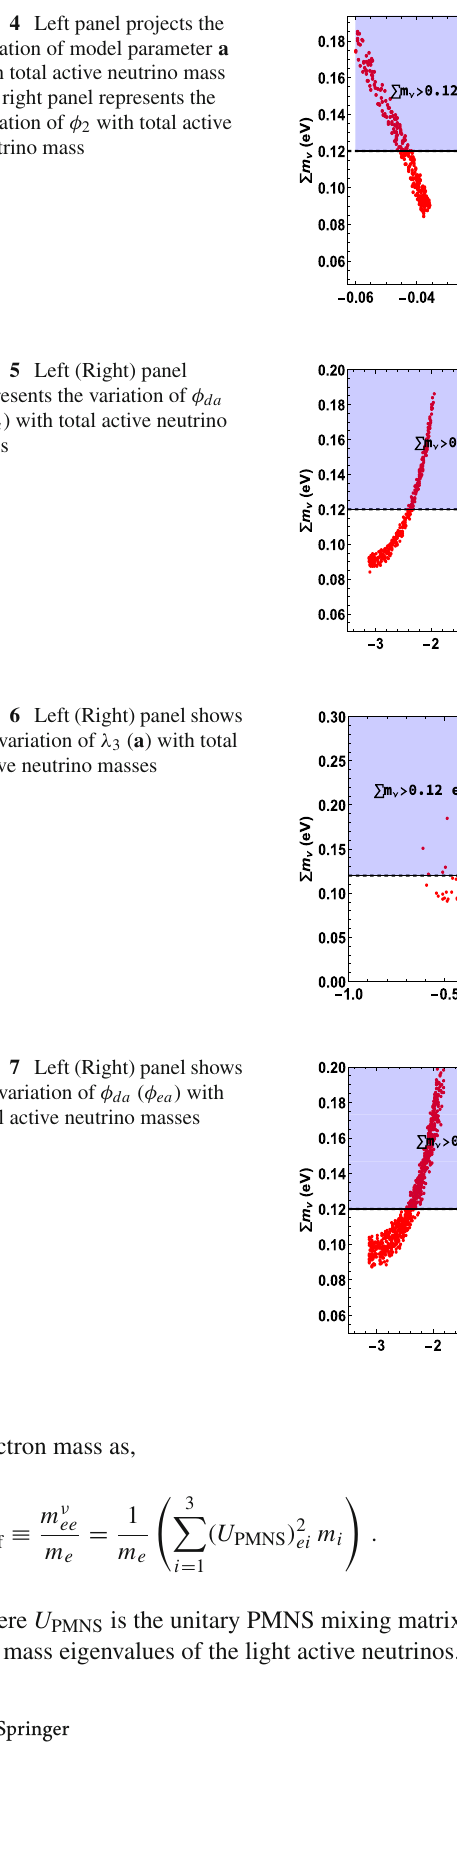
Fig. 5 Left (Right) panel represents the variation of φ da ( φ ea ) with total active neutrino mass